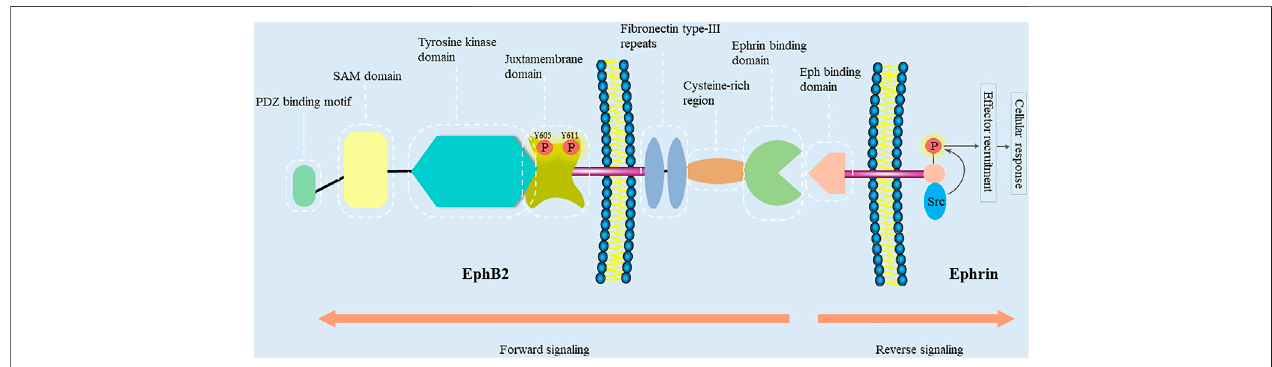
FIGURE 1 | EphB2 and ephrin domain structure and their interacting proteins. Eph receptors contain an N-terminal multidomain extracellular region, a membrane spanning region, and an intracellular region. The intracellular region encompasses a juxtamembrane region, a tyrosine kinase domain, a sterile- α -motif (SAM) domain, andaPDZ-bindingmotif.Theextracellularregionincludestwo fi bronectintype-IIIrepeats,acysteine-richdomain(containinganepidermalgrowthfactor(EGF)-likemotif), and an ephrin-binding region. Bidirectional signaling causes forward signaling via Eph receptors and reverse signaling via ephrin ligands. The cellular response caused by Eph/ephrin reverse signaling depends on the intracellular environment. In general, ephrin-B binding of EphB receptors results in the recruitment of Src family kinase and the phosphorylation of the intracellular region of ephrin-B (Kania and Klein, 2016).